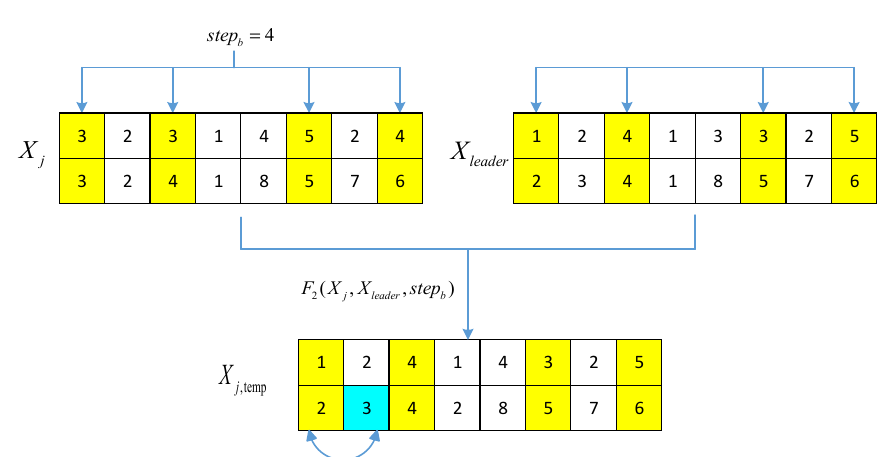
Figure 3. Operation in calling behavior. step b columns in X j are randomly selected and are replaced by the corresponding columns of the leader wolf, while the duplicate value in the second row is replaced with the original value in the changed column.